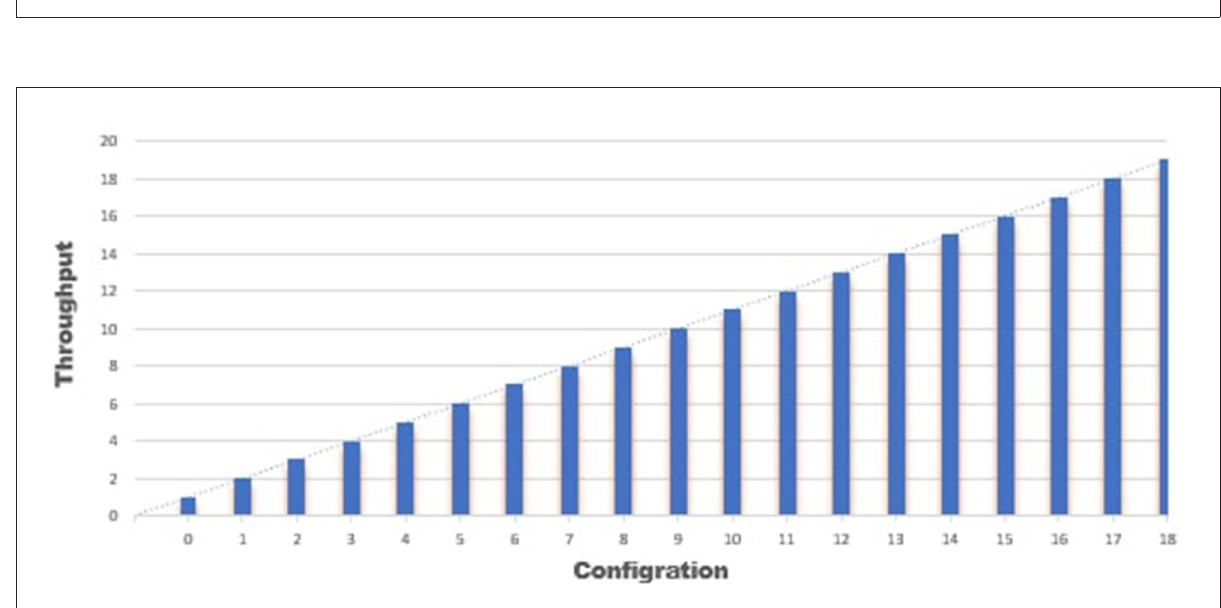
FIGURE7 Performance